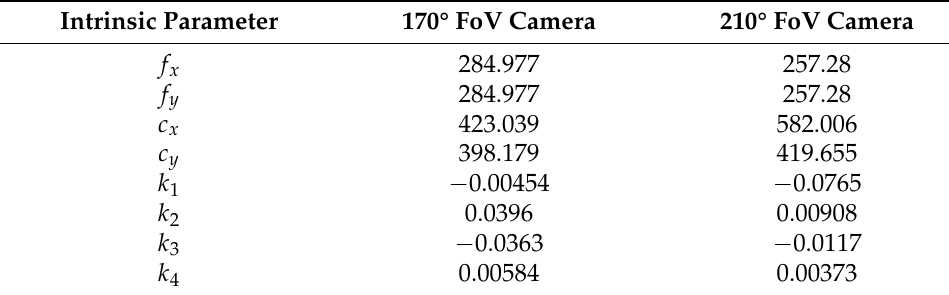
Table 1. The Intrinsic Parameters of 170° FoV and 210° FoV